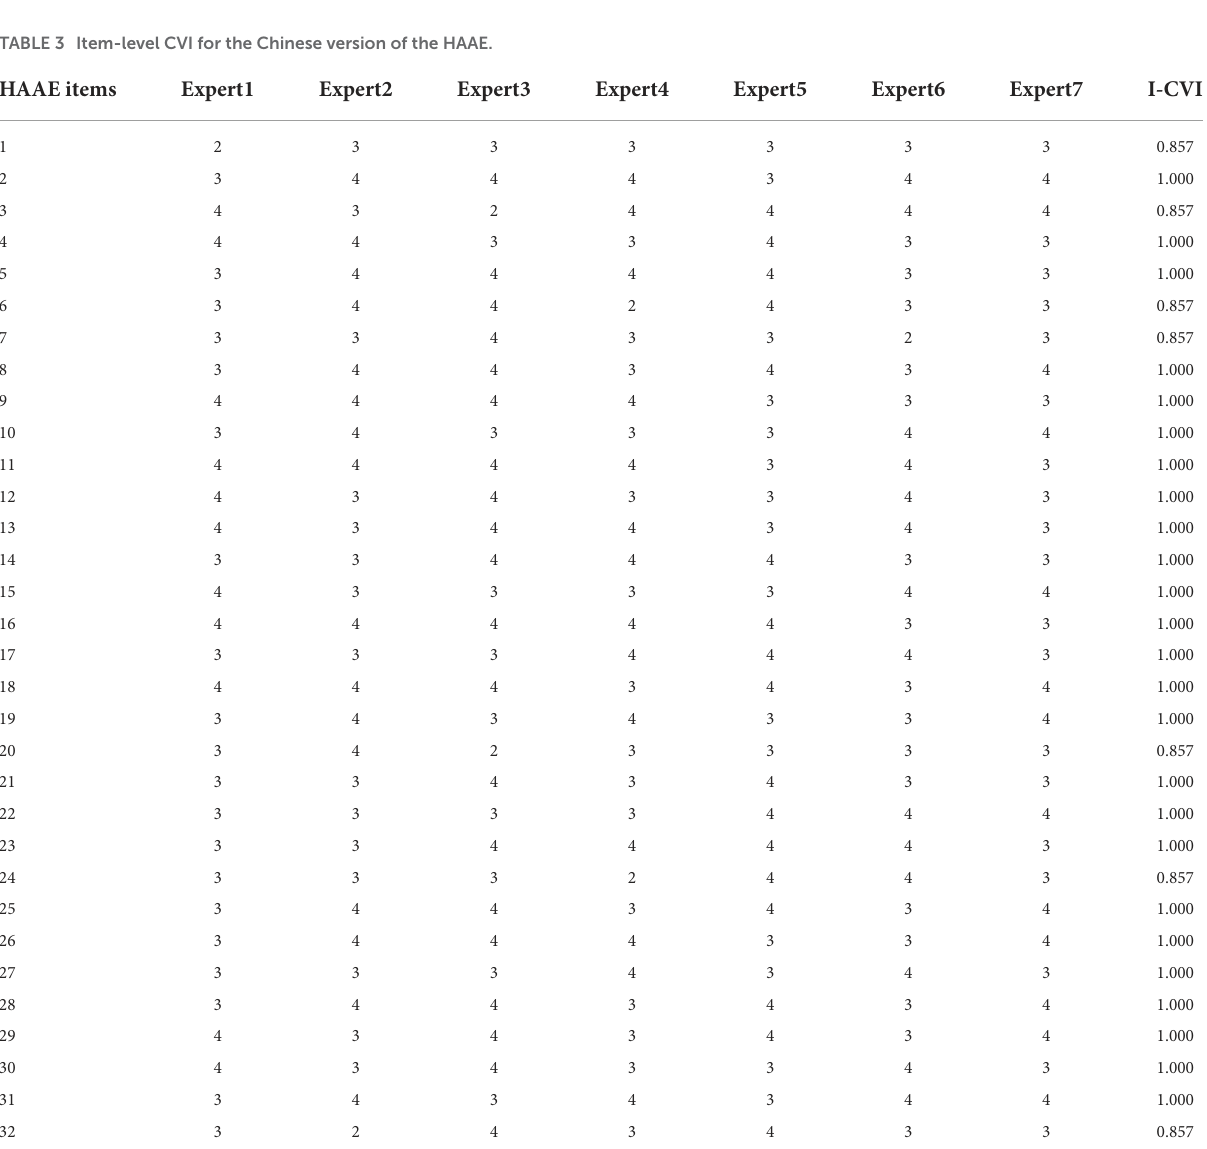
TABLE 3 Item-level CVI for the Chinese version of the HAAE. HAAE